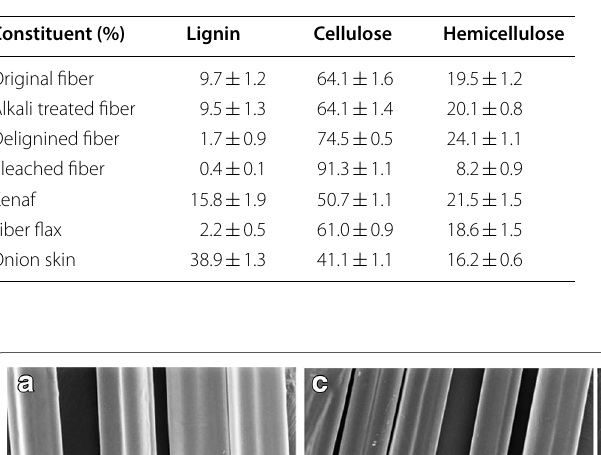
Table 1 Chemical composition of Calotropis procera fiber